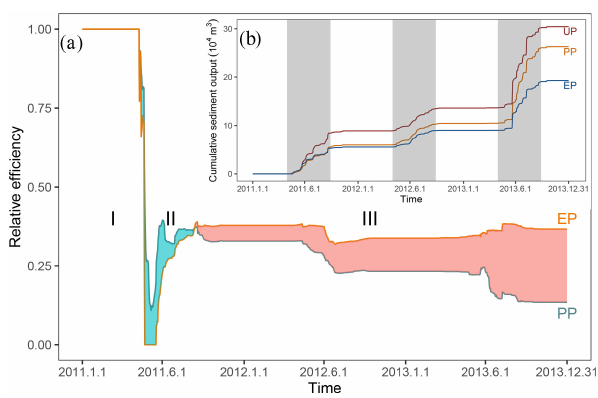
Figure 10. (a) Relative efficiencies of Scenarios UP and EP com- pared with that of Scenario UP (cyan shading represents when PP is more effective than EP and red shading represents the opposite). (b) Cumulative sediment yield over time (grey region highlighting three